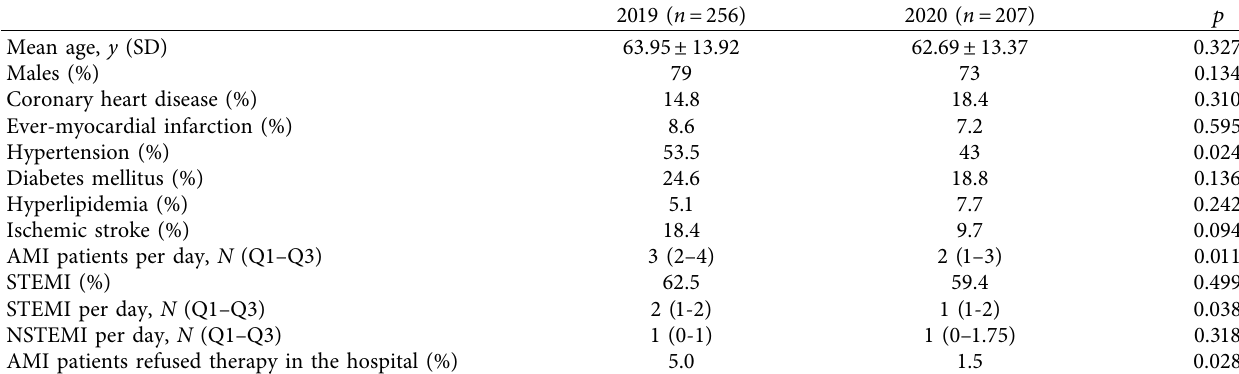
Table 1: Clinical characteristics of AMI inpatients.